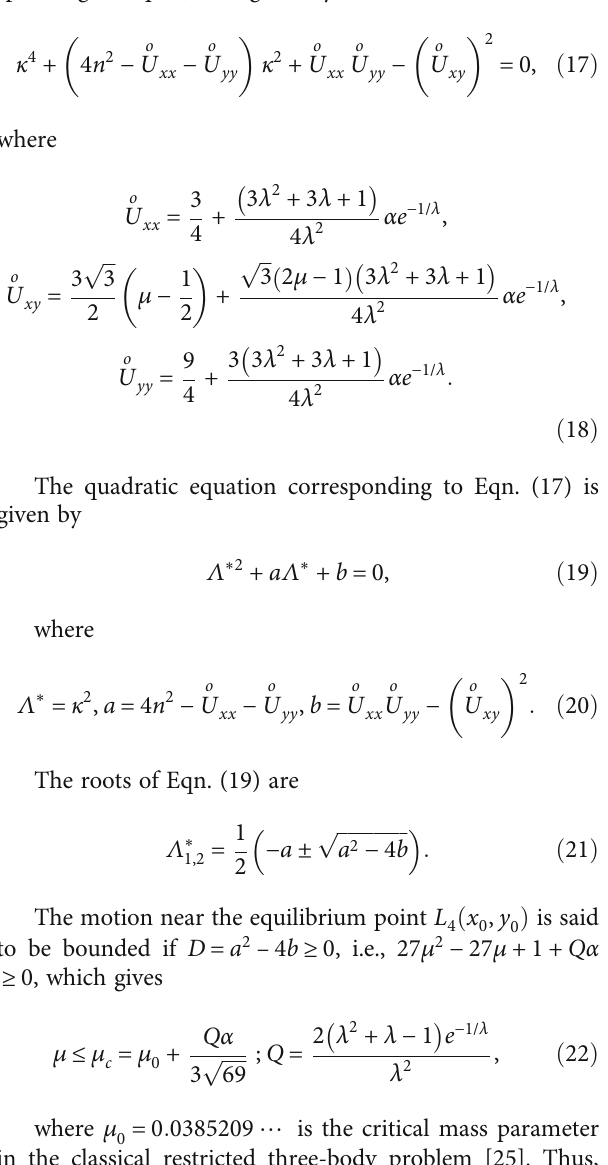
= 0 : 618034 and Q > 0 in the interval 0 : 618034 < λ < ∞ . Thus, μ c = μ 0 either for α = 0 or λ = 0 : 618034 . Figure 4, λ = 1/3 is a critical point at which the critical mass parameter μ c has maximum and minimum values in the interval < α < 1